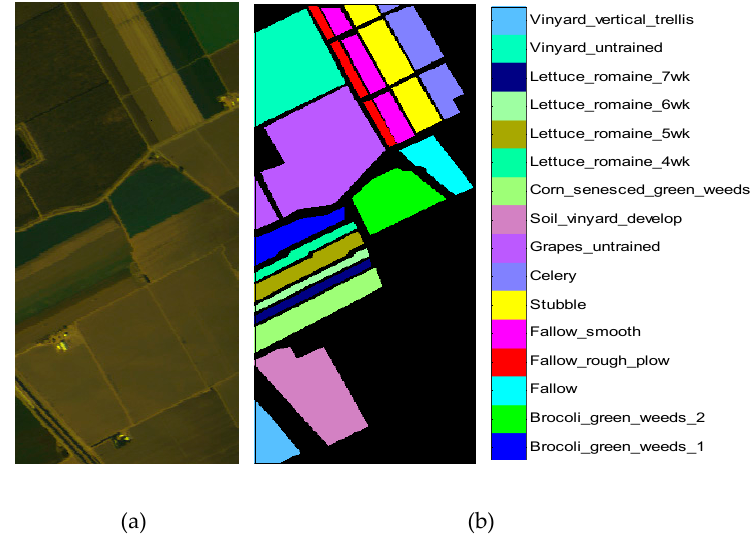
Figure 7. ( a ) False-color image of the Salinas data, ( b ) Ground truth of the Salinas Figure 7. (a) False-color image of the Salinas data, (b) Ground truth of the Salinas data.